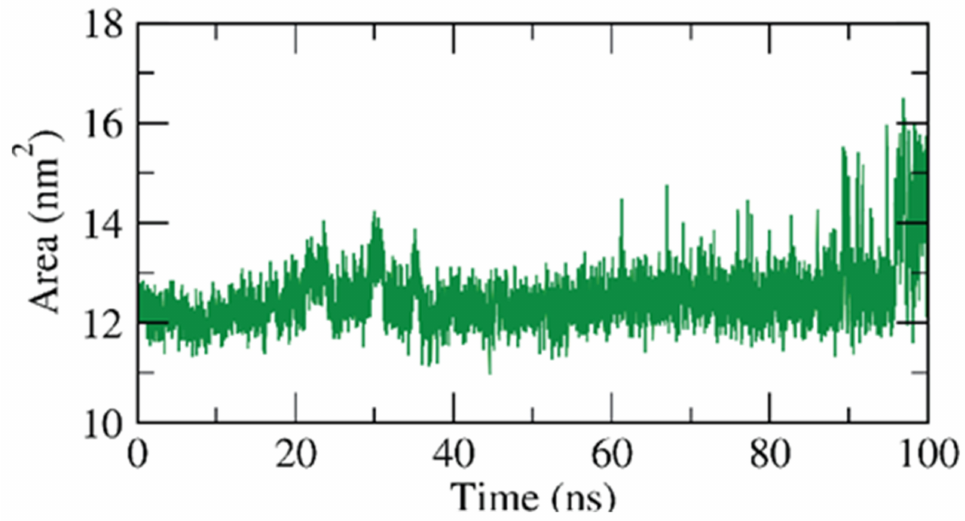
Figure 9. SASA of β CD-anabasine complex.